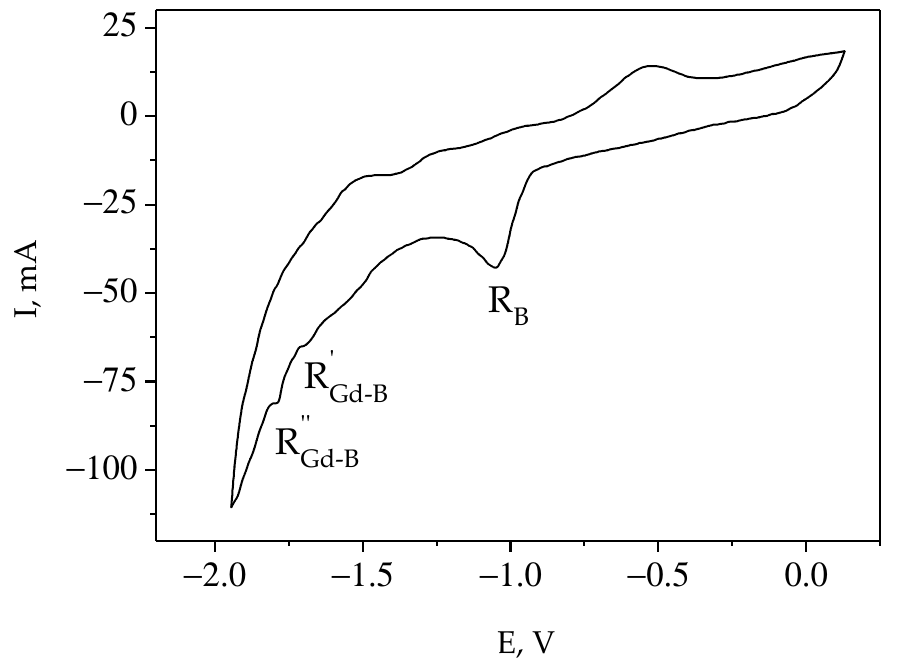
= (cid:3012)(cid:3003)(cid:3007) (cid:3120)